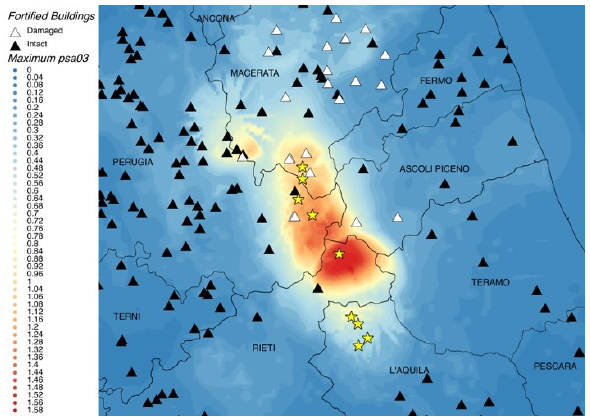
Figure 7. Interpolation of the psa’s maximum values with a 0.3 s period, of the seismic sequence that hit Central Italy since August